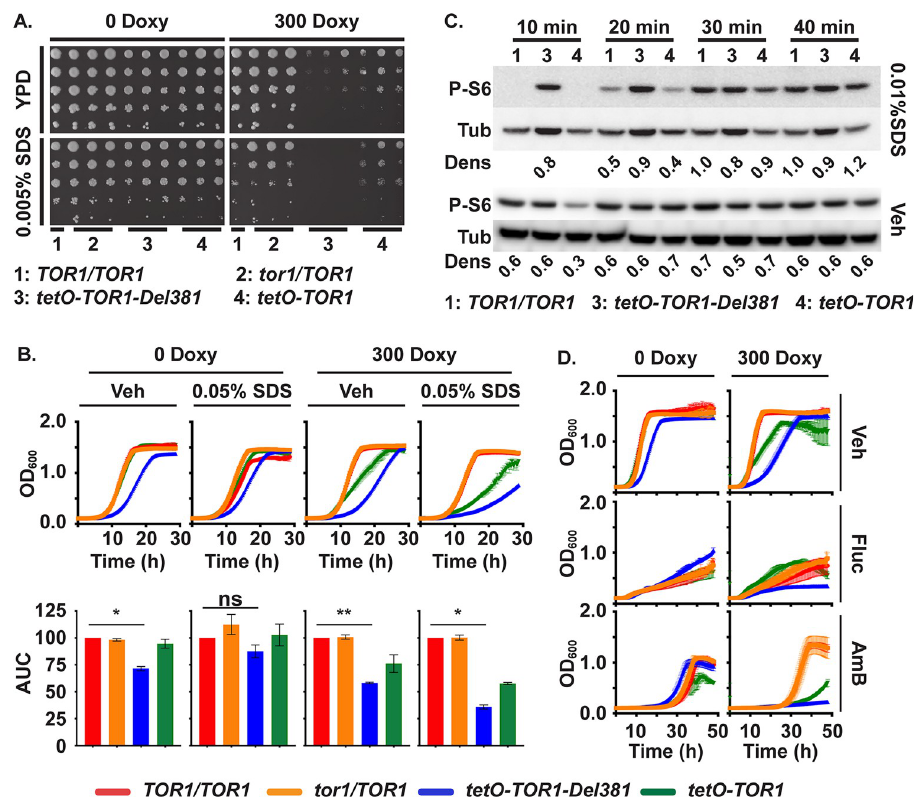
Fig 8. Plasma membrane stress responses did not significantly depend on Tor1 N-terminal HEAT repeats. A. Dilutions of cells of indicated genotypes were spotted on YPD medium without or with doxycycline (300 Doxy) and plasma membrane stress was induced with 0.005% SDS. ( TOR1/TOR1 , JKC1713; tor1/TOR1 , JKC1345, JKC1346, JKC1347; tetO-TOR1-Del381 , JKC1442, JKC1445, JKC1441; tetO-TOR1 , JKC1543, JKC1546, JKC1549). B. Cells of indicated genotypes were grown in YPD medium containing Vehicle (Veh, H 2 O) or 0.05% SDS, without or with 300 ng/ml doxycycline. Upper panel shows the actual growth curves and lower panel shows the corresponding area under the curve (AUC) for each strain. �� is p = 0.0076; � is p = 0.029 (Veh, 0 Doxy) and p = 0.0129 (0.05% SDS, 300 Doxy); ns is p = 0.2, error bars show SD of 2 biological replicates ( TOR1/TOR1 , JKC1713; tor1/TOR1 , JKC1347; tetO-TOR1-Del381 , JKC1441; tetO-TOR1 , JKC1549). C. Cells of indicated genotypes were pre-grown in YPD medium with 5 ng/ml doxycycline for 3.5 h, then diluted into fresh YPD medium containing either Vehicle (Veh, H 2 O) or 0.01% SDS and incubated for the indicated times. Total protein extract was probed with antibody to phosphorylated Rps6 (P-S6) and tubulin (Tub) as loading control. Dens: signal intensity ratio of P-S6 to Tub; strains as in panel B. D. Cells were grown as in B but treated with 1 μ g/ml Fluconazole (Fluc) or 0.2 μ g/ml Amphotericin B